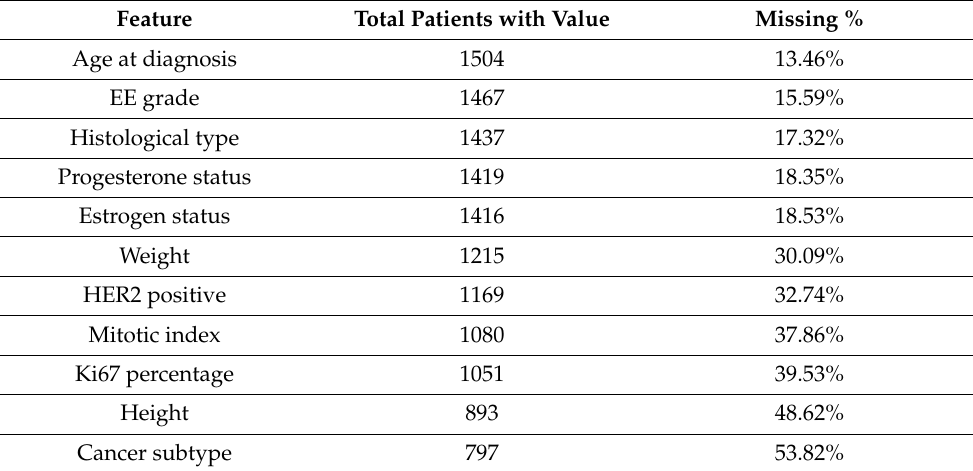
Table A1. Key feature characteristics in the